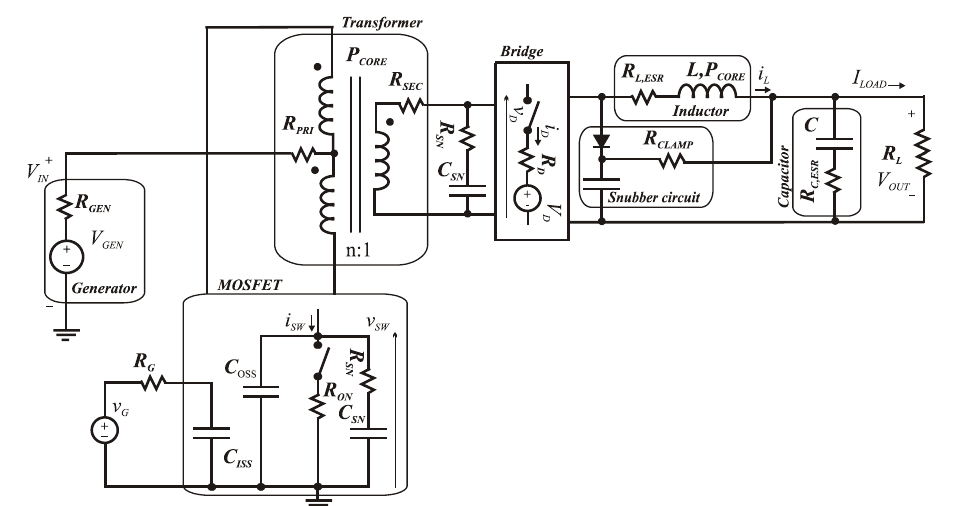
Figure 2. Equivalent circuit of push–pull converter with parasitic elements.